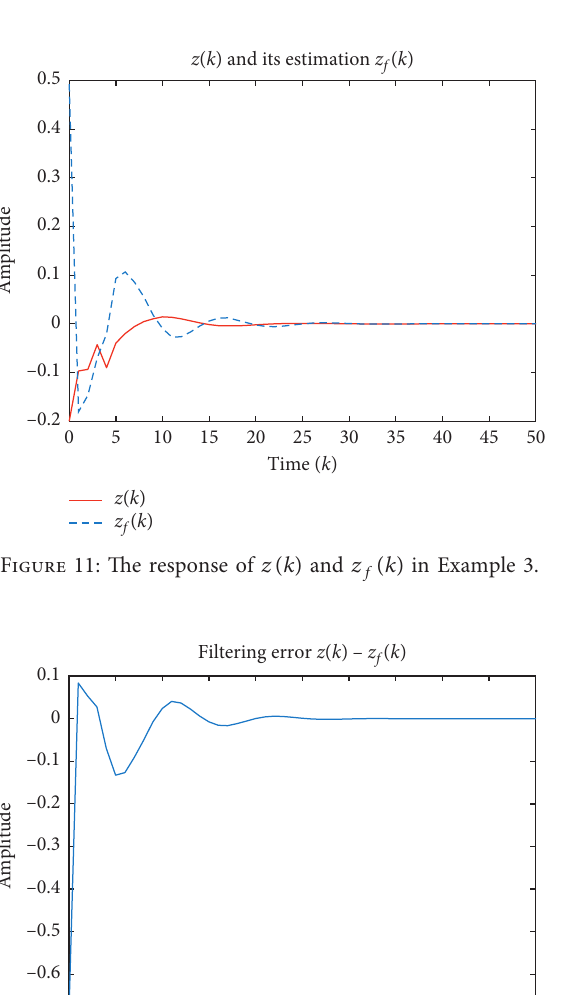
Figure 12: The filtering error in Example